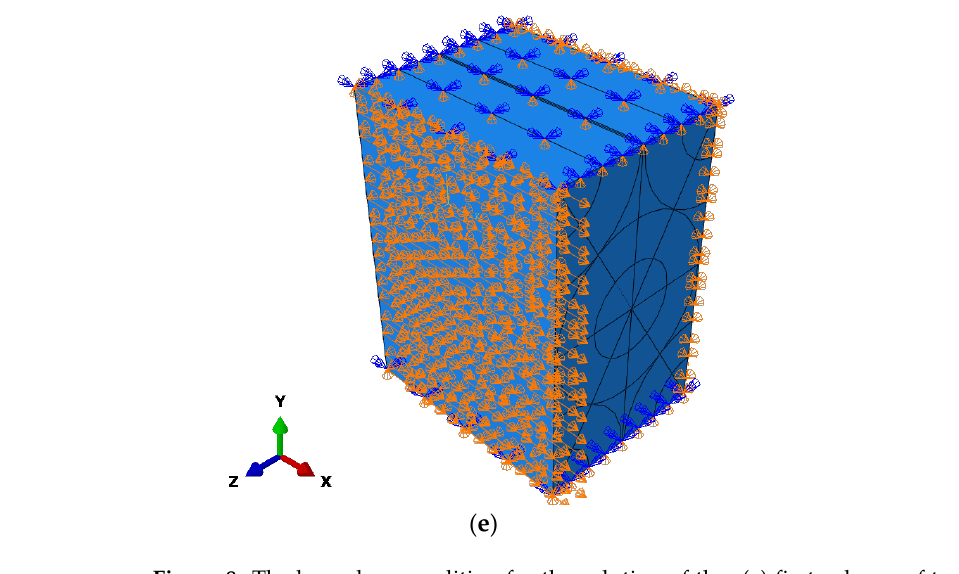
Figure 8. The boundary condition for the solution of the: ( a ) first column of tensor C; ( b ) second column of tensor C; ( c ) third column of tensor C; ( d ) fourth column of tensor C; and ( e ) sixth column of tensor C.